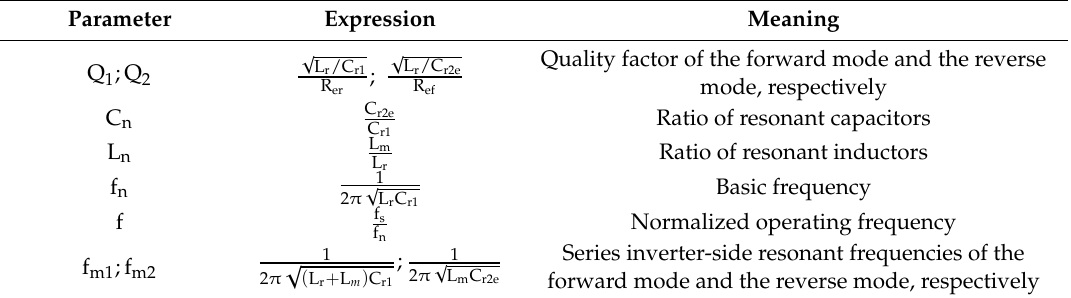
Table 1. Auxiliary parameters’